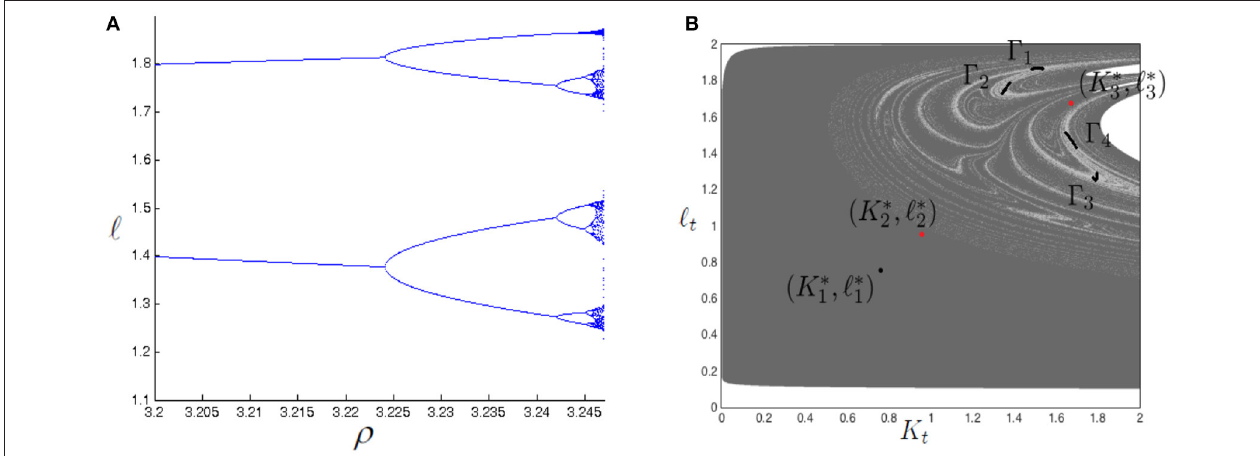
FIGURE 12 | Figure reproduced with the permission of the publisher. Source: Antoci et al. [18]. (A) Bifurcation diagram for ρ . Due to the rise of attractors with rather tangled basins of attraction, the initial conditions were opportunely adapted to the change in ρ in order to follow the evolution of each attractor. (B) Basins of attraction when the attracting fixed point ( K * 1 , l * 1 ) coexists with a four-piece chaotic attractor ( ρ =